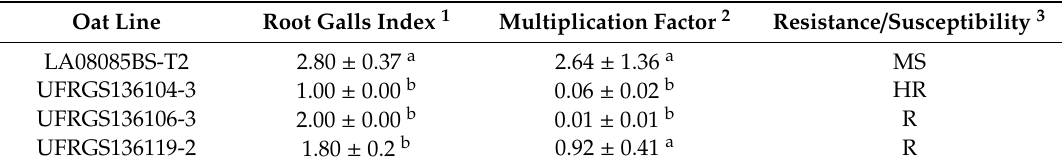
Table 4. Evaluation of the resistance and susceptibility of oat lines to M. graminicola based on root galls index and multiplication